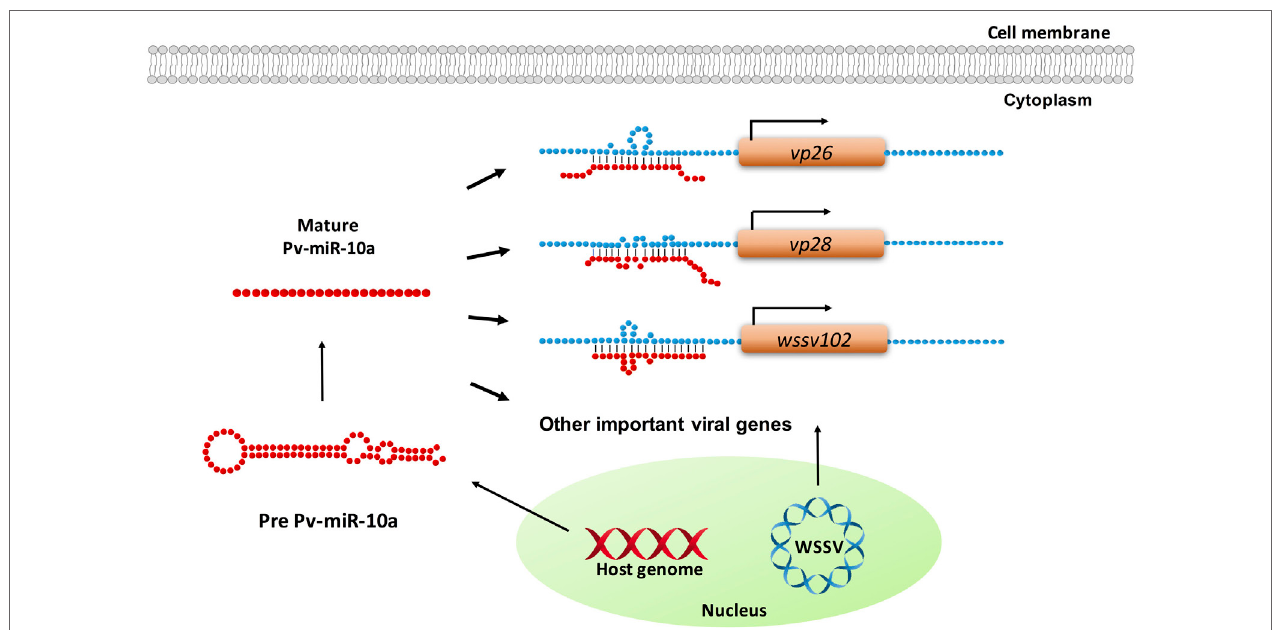
FigUre 5 | Schematic representation of how shrimp miR-10a is co-opted by white spot syndrome virus (WSSV) to enhance viral replication. Pv-miR-10a upregulates the expression of at least three WSSV genes ( vp26 , vp28 , and wssv102 ) by targeting their 5 ′ untranslated region. Alignment followed by RNAhybrid prediction suggests that several other important WSSV genes are also likely to be upregulated by host